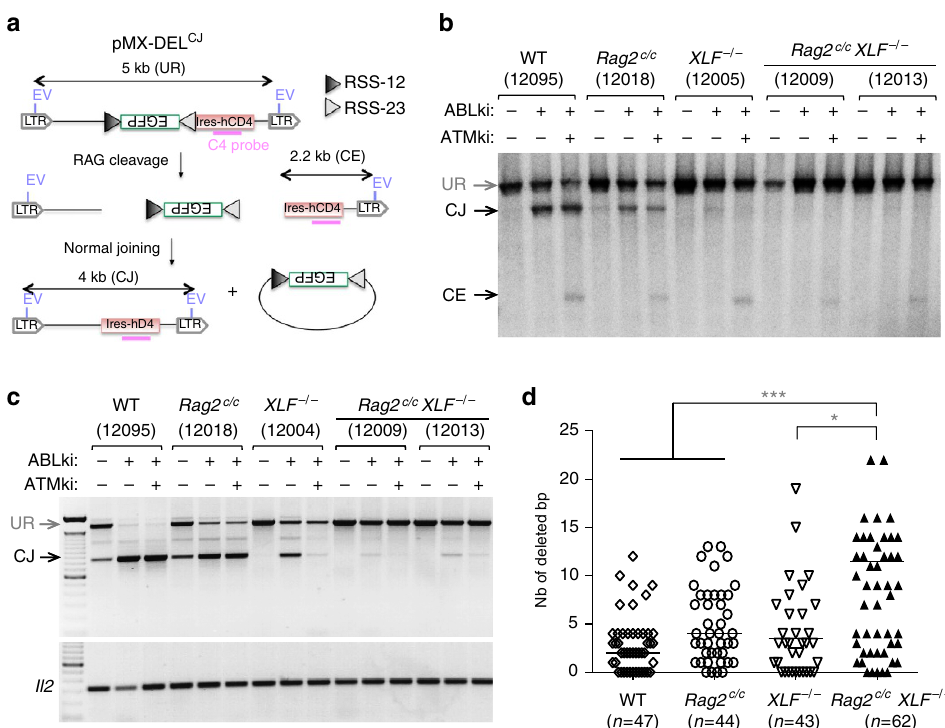
Figure 5 | Defective deletional V(D)J recombination and abnormal CJ formation in Rag2 c/c XLF (cid:2) / (cid:2) B cells. ( a ) Schematic representation of pMX-DEL CJ recombination substrate with components, intermediates and products as defined for pMX-INV in Fig. 4a. ( b ) v-abl pro-B cell lines containing pMX-DEL CJ were treated for 72h with ABLki with or without ATMki and assayed by Southern blotting; EcoRVdigest—C4 probe. Experiments were repeated at least two times. ( c ) PCR analysis of pMX-DEL CJ CJs from indicated v-abl abl pro-B cell lines treated for 72h with ABLki with or without ATMki. Il2 gene PCR was used as a loading control. Experiments were repeated at least two times and PCR specificity was confirmed by Southern blotting (Supplementary Fig. 8). ( d ) Sanger sequencing of PCR amplified CJs from v-abl pro-B cells (see also Supplementary Table 2). Number of base-pair deletions is indicated on the y -axis. The horizontal bar represents the median. The total number of sequenced CJs ( n ) is indicated. Outliers ( 4 25bp deletion) are not shown but are included in calculation of the median. *0.01 r P o 0.05, *** P o